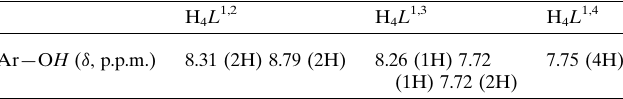
Table 2 1 H NMR resonances for the phenolic protons of three regioisomers in CDCl 3